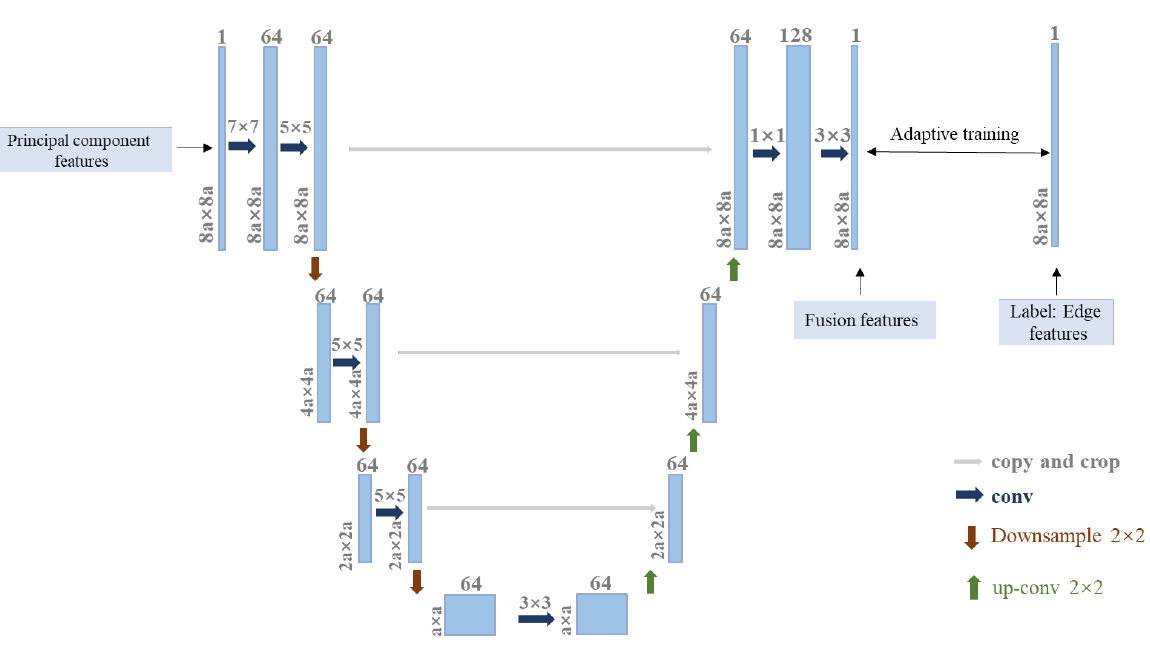
Figure 2. U-shaped deep adaptive fusion model.